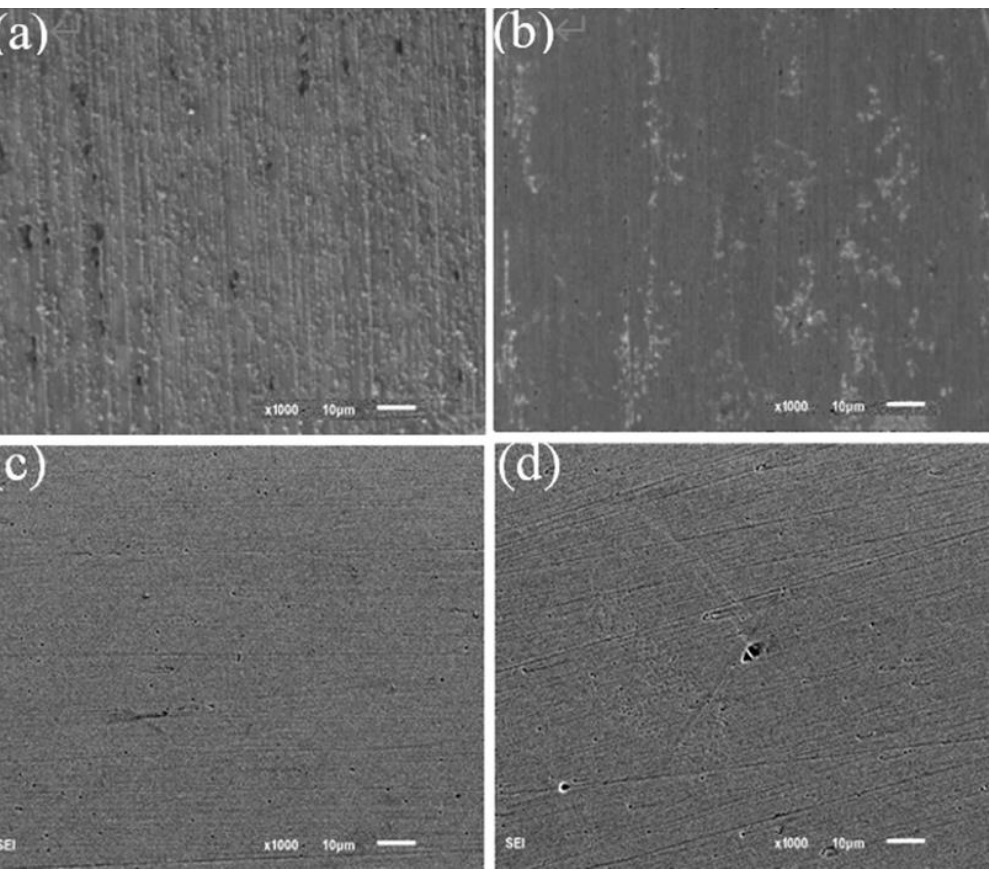
Figure 14. Corrosion of TP2 copper soaked in acetic acid solution with corrosion inhibitor: ( a ) 0.05 g/L; ( b ) 0.1 g/L; ( c ) 0.5 g/L; ( d ) 1.0 g/L.